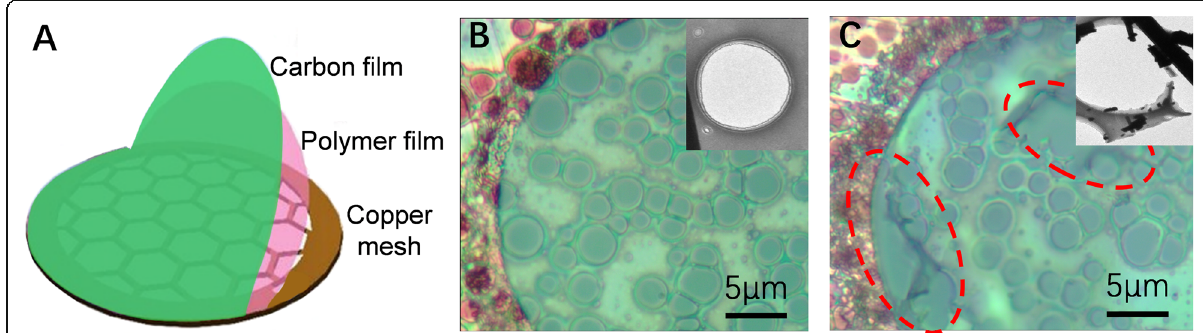
Fig. 1 Structure and property of TEM grid. a structure of TEM grid for nanomaterials, from top to bottom are carbon film, organic polymer film and copper mesh. b optical microscope and TEM images (inset) of unbroken TEM grid. c optical microscope and TEM images (inset) destroyed by methylbenzene